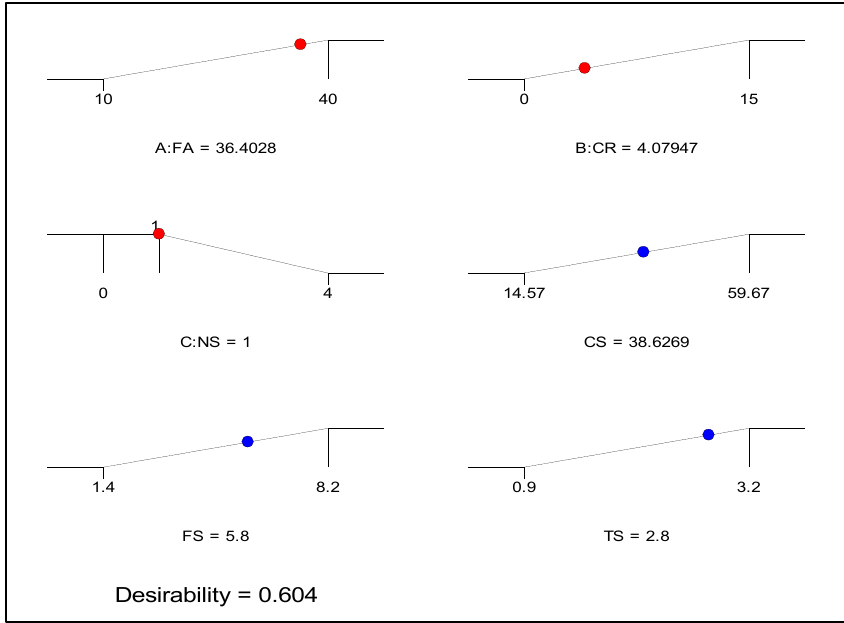
Figure 18. Optimization solution ramp.